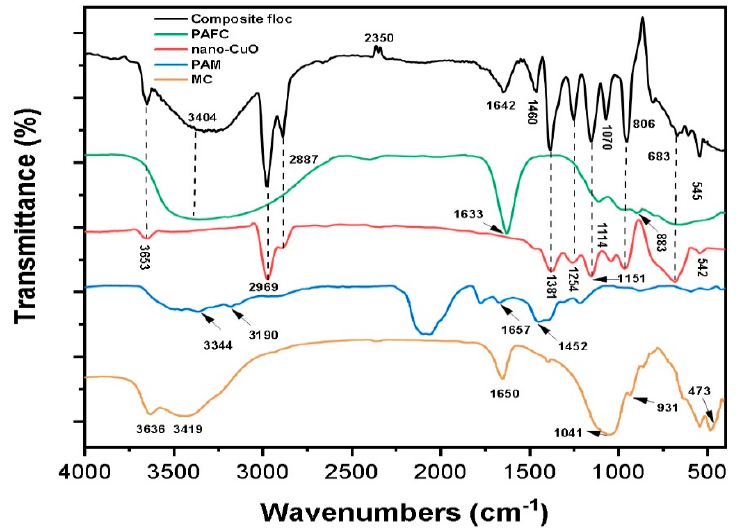
Figure 7. FT-IR spectrum of pristine chemicals, i.e., MC, PAM, nano-CuO, PAFC and composite flocs obtained at optimum C/F/S conditions. obtained at optimum C/F/S